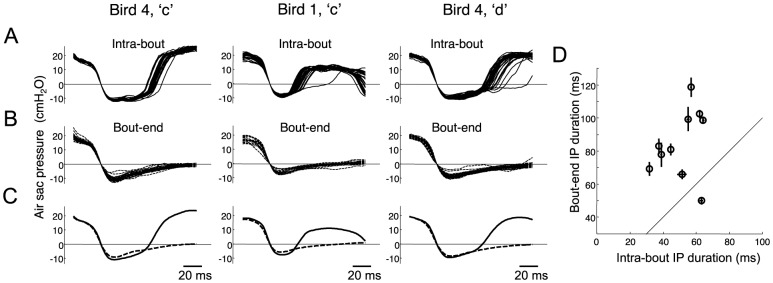
IPs are longer at bout offset.A) Examples of identified IPs produced within a song bout, where there was a following syllable. B) Examples of the same IPs produced at bout-end, where there was no following syllable. C) Average of the intra-bout IPs (solid) and bout-end IPs (dashed). D) Scatter plot of duration of IPs following bout-ending syllable renditions versus intra-bout syllable renditions for the 10 syllables that occurred at bout-ends with sufficient frequency to be analyzed.